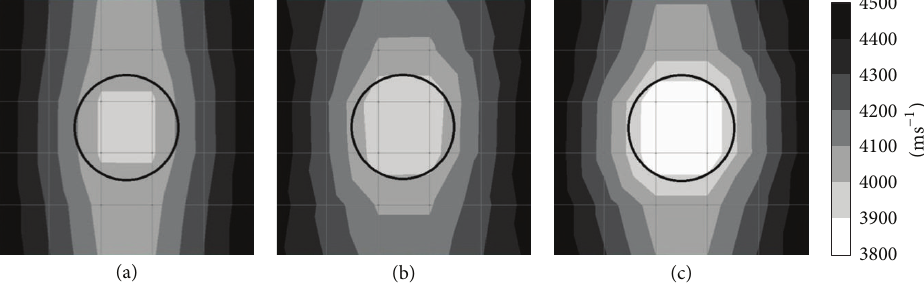
Figure 8: Tomograms simulated by 25 elements: (a) 0% void; (b) 50% void; and (c) 100% void.